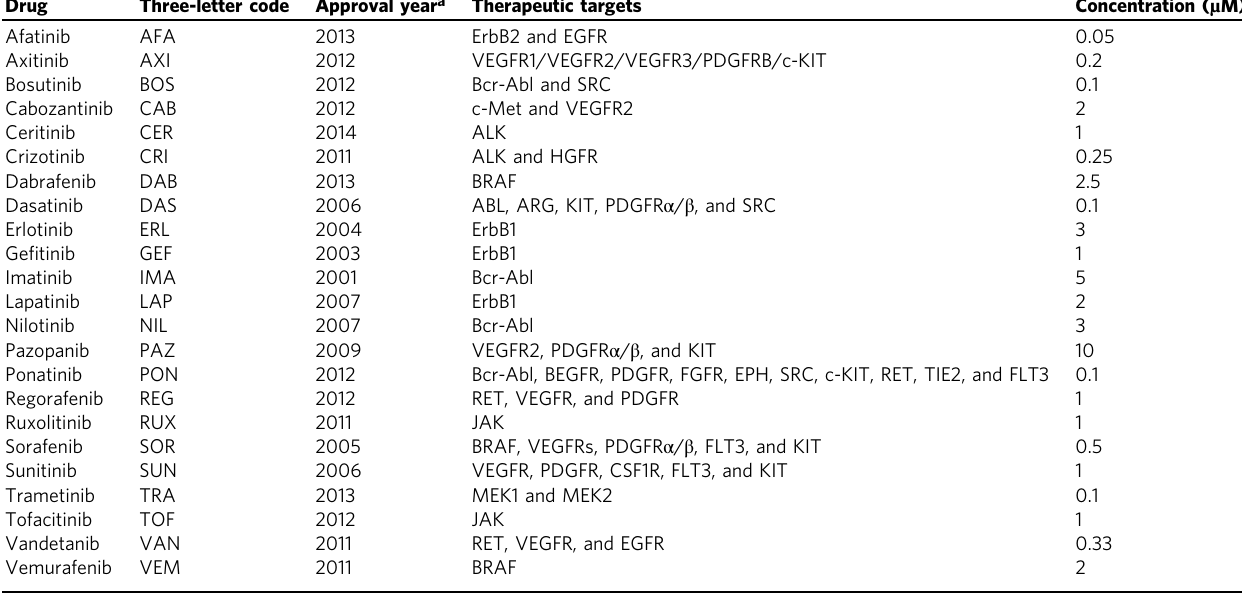
Table 1 Overview of KIs included in this